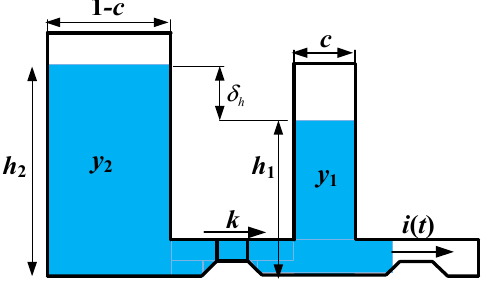
Figure 2. Kinetic battery model (KiBaM).